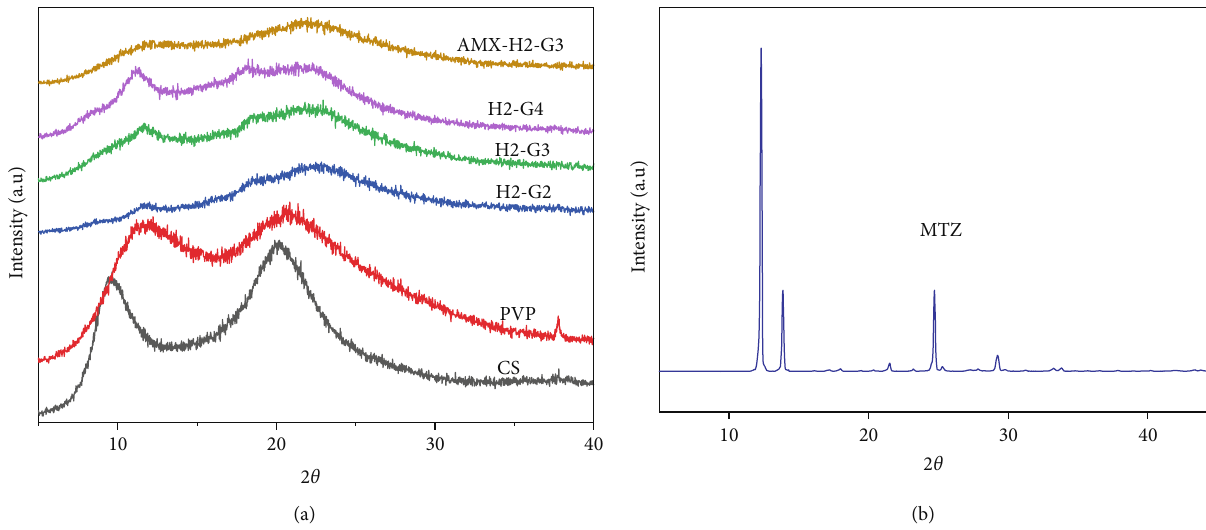
Figure 5: XRD di ff ractograms of (a) pristine CS, PVP, and hydrogels H2-G2 to H2-G4 and MTZ-H2-G3 (b) pristine MTZ.